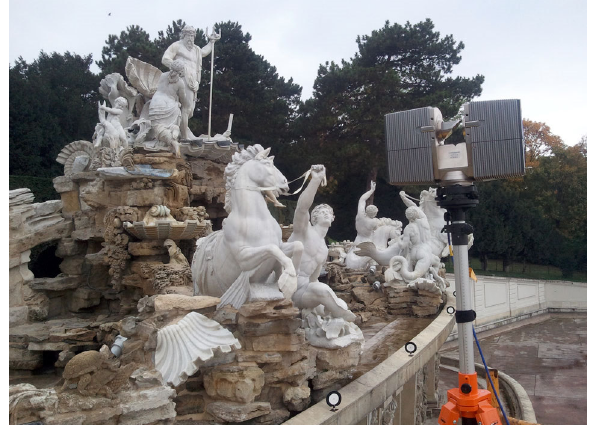
Figure 4. Scanning position on top of the scaffold and planar targets for registration arranged along the border of the cascade basin.